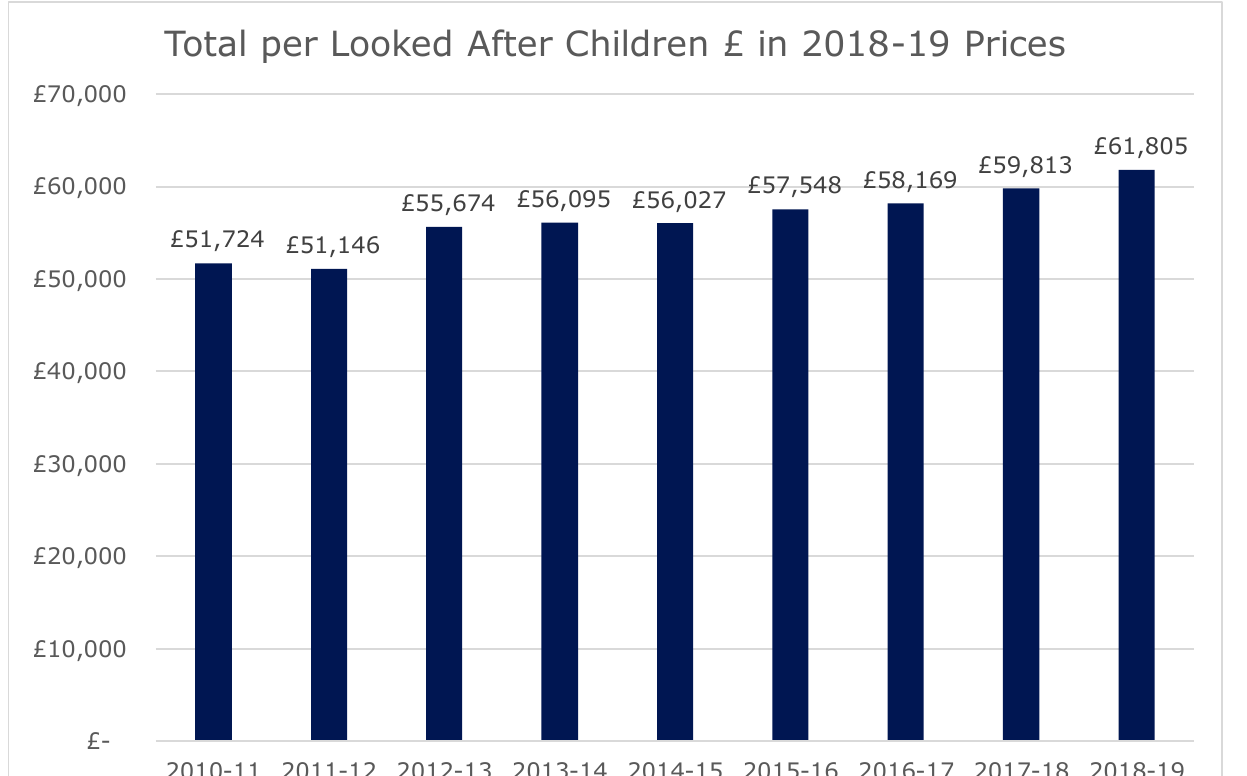
Spend in Spend in Change from 2010/11 Change from 2010/11 Area of spending 2010/11 (mn) 2018/19 (mn) to 2018/19 (mn) to 2018/19 Looked-after children £3,334 £4,659 +£1,324 +40% Safeguarding 35 £1,906 £2,342 +£435 +23% Youth justice £314 £153 -£161 -51% Total £5,554 £7,153 +£1,599